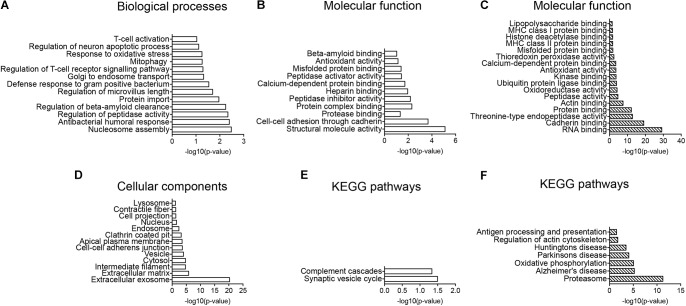
GO-term and enrichment of KEGG pathways analysis. (A,B,D,E) GO-term analysis of protein pathways enriched in the CD11b+ cell proteome of Tg versus Wt (A,B,D) and enrichment of KEGG pathways (E). (A) Enrichment of biological processes. (B) Enrichment of molecular function. (D) Enrichment of cellular components. (C,F) GO-term enrichment analysis of molecular functions (C), and enrichment of KEGG pathways (F) in potential CD11b+ cell proteins in hippocampus. Data was analyzed by the DAVID software.